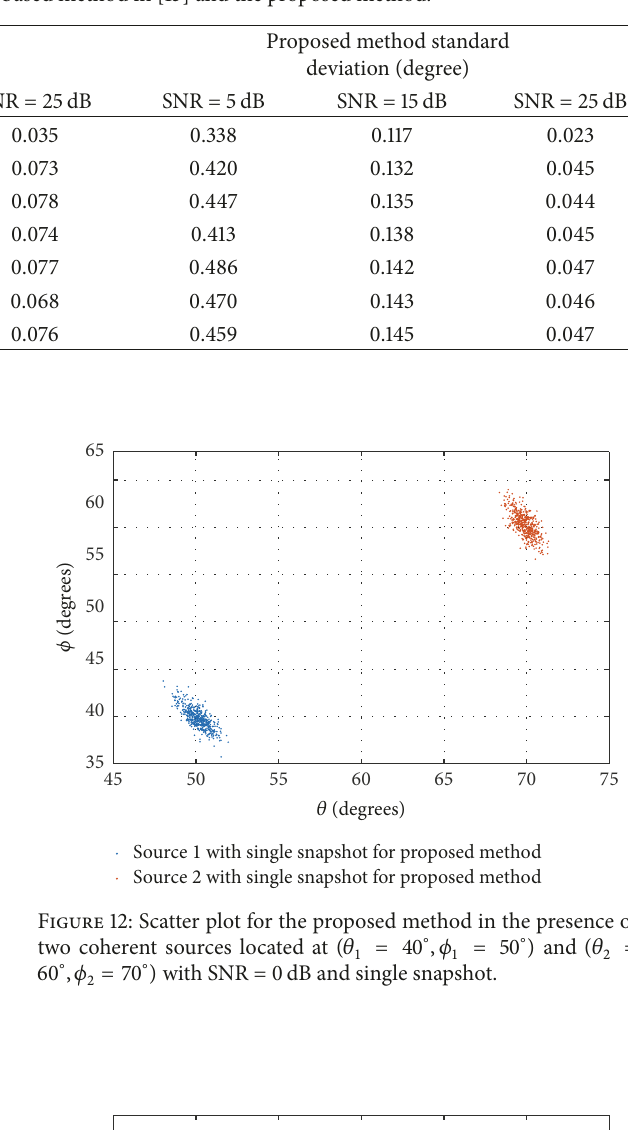
Table 1: Comparison between the cumulant-based method in [15] and the proposed method.